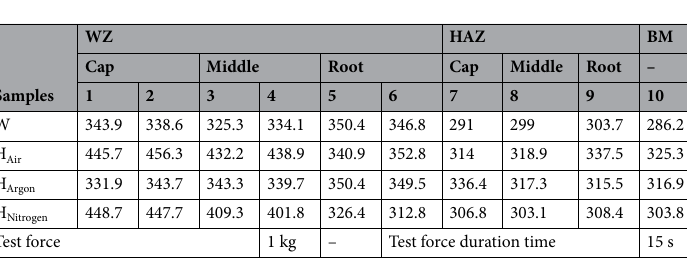
Table 4. Hardness values of samples in different 10 points in each sample.